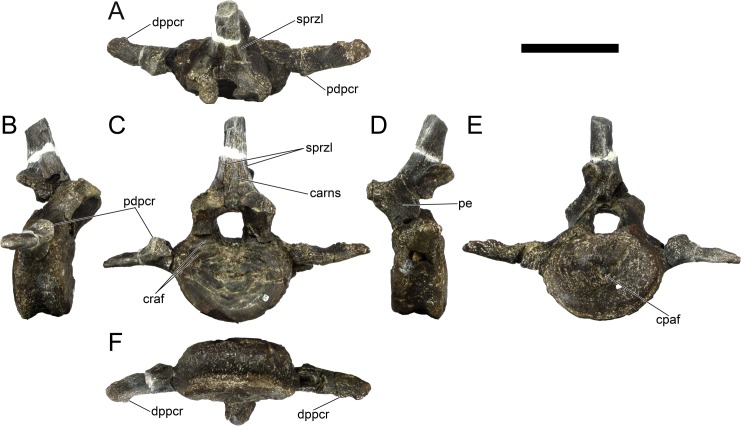
Caudal vertebra five of Miragaia longicollum MG 4863.A, dorsal, B, right lateral, C, anterior, D, left lateral, E, posterior, and F, ventral view. Carns, central anterior ridge of neural spine, cpaf, central process of articular facet, craf, concentric ridges of articular facet, dppcr, distaloposterior process of caudal ribs, pe, pedicel, pdpcr, proximodorsal process of caudal rib, sprzl, spinoprezygapophyseal lamina. Scale bar equal to 10 cm.